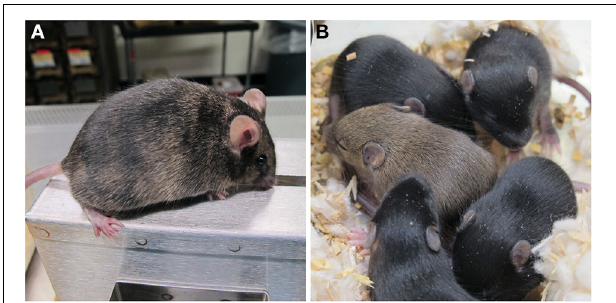
FIGURE 5 | Pigl gene-trap mutant mice. (A) Pigl PB / + male chimera. A fertile, germline competent chimera produced by microinjection of Pigl PB / + ES cells is shown. The chimerism was exhibited in the ES cell specific coat color (agouti) on a non-agouti host background (C57BL/6). (B) F1 pups from Pigl PB / + chimera. One of the litters produced by crossing a wild-type inbred C57BL/6 female with the Pigl PB / + chimera is shown. The agouti progeny indicated germline transmission. Further genotyping by PCR confirmed the inheritance of the gene-trapped Pigl allele.